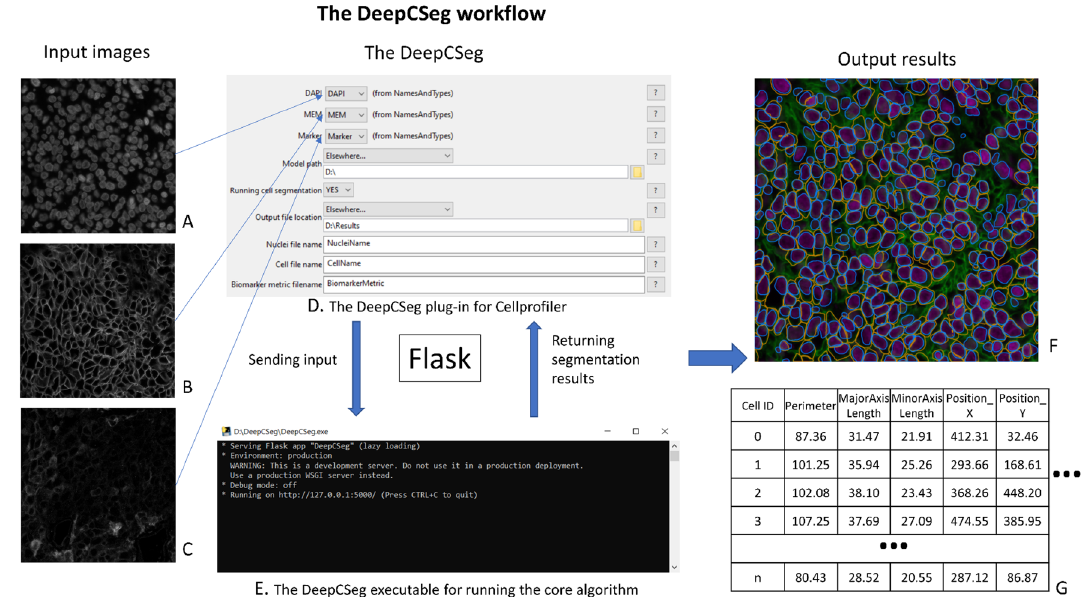
Figure 8. The DeepCSeg plug-in workflow. The input images are the immunofluorescence multiplexed images stained with ( A ). DAPI, ( B ) Na + K + ATPase, and ( C ) pan-cytokeratin. There are two components in DeepCSeg: ( D ) the plug-in for the CellProfiler and ( E ) the executable for implementing the core algorithm. Flask is the framework that is used for the communication between the two components. ( F ) shows the output results for whole cell and nuclear segmentation on the color image, which is synthesized from ( A ) and ( B ) in the R-G-B color mode. The yellow contours identify the cell boundaries, and the blue contours identify the nuclear boundaries. ( G ) The quantitative measurement (e.g. cell central location, size, mean intensities etc.) for each cell for the testing biomarker image ( C ), which is computed using the whole cell and nuclear segmentation results. This figure is created using diagrams.net (https:// www. diagr ams.